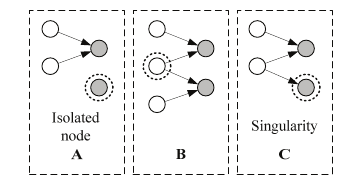
Figure 3: links between initial (white nodes) and generalized (dark nodes)